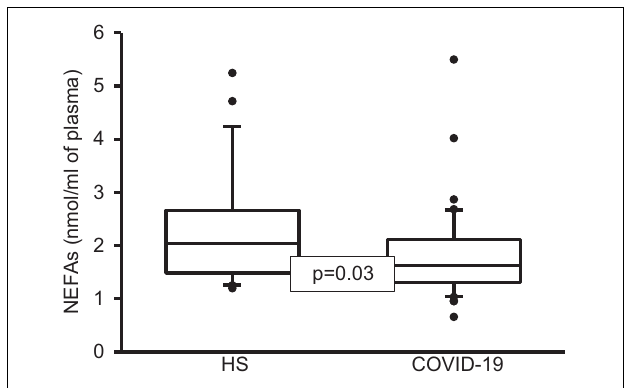
FIGURE 2 | Total NEFAs in plasma of healthy subjects and COVID-19 patients. A decrease significant is observed in COVID-19 patients vs. HS. Statistical significance was determined by the Mann–Whitney rank sum test followed by the normality test (Shapiro-Wilk). Values expressed represent the median and Min–Max range ( n = 42 COVID-19 patients and 22 HS). COVID-19 = coronavirus disease-19, HS = healthy subjects, NEFAS = non-esterified fatty